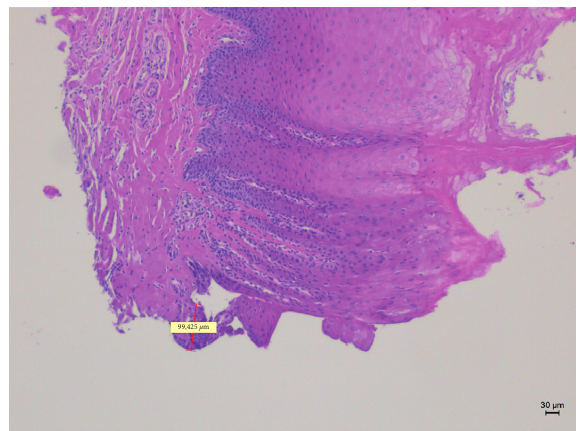
Figure 5: The histological specimen obtained using 5W in PW with colour EE at 10x magnification (group E).